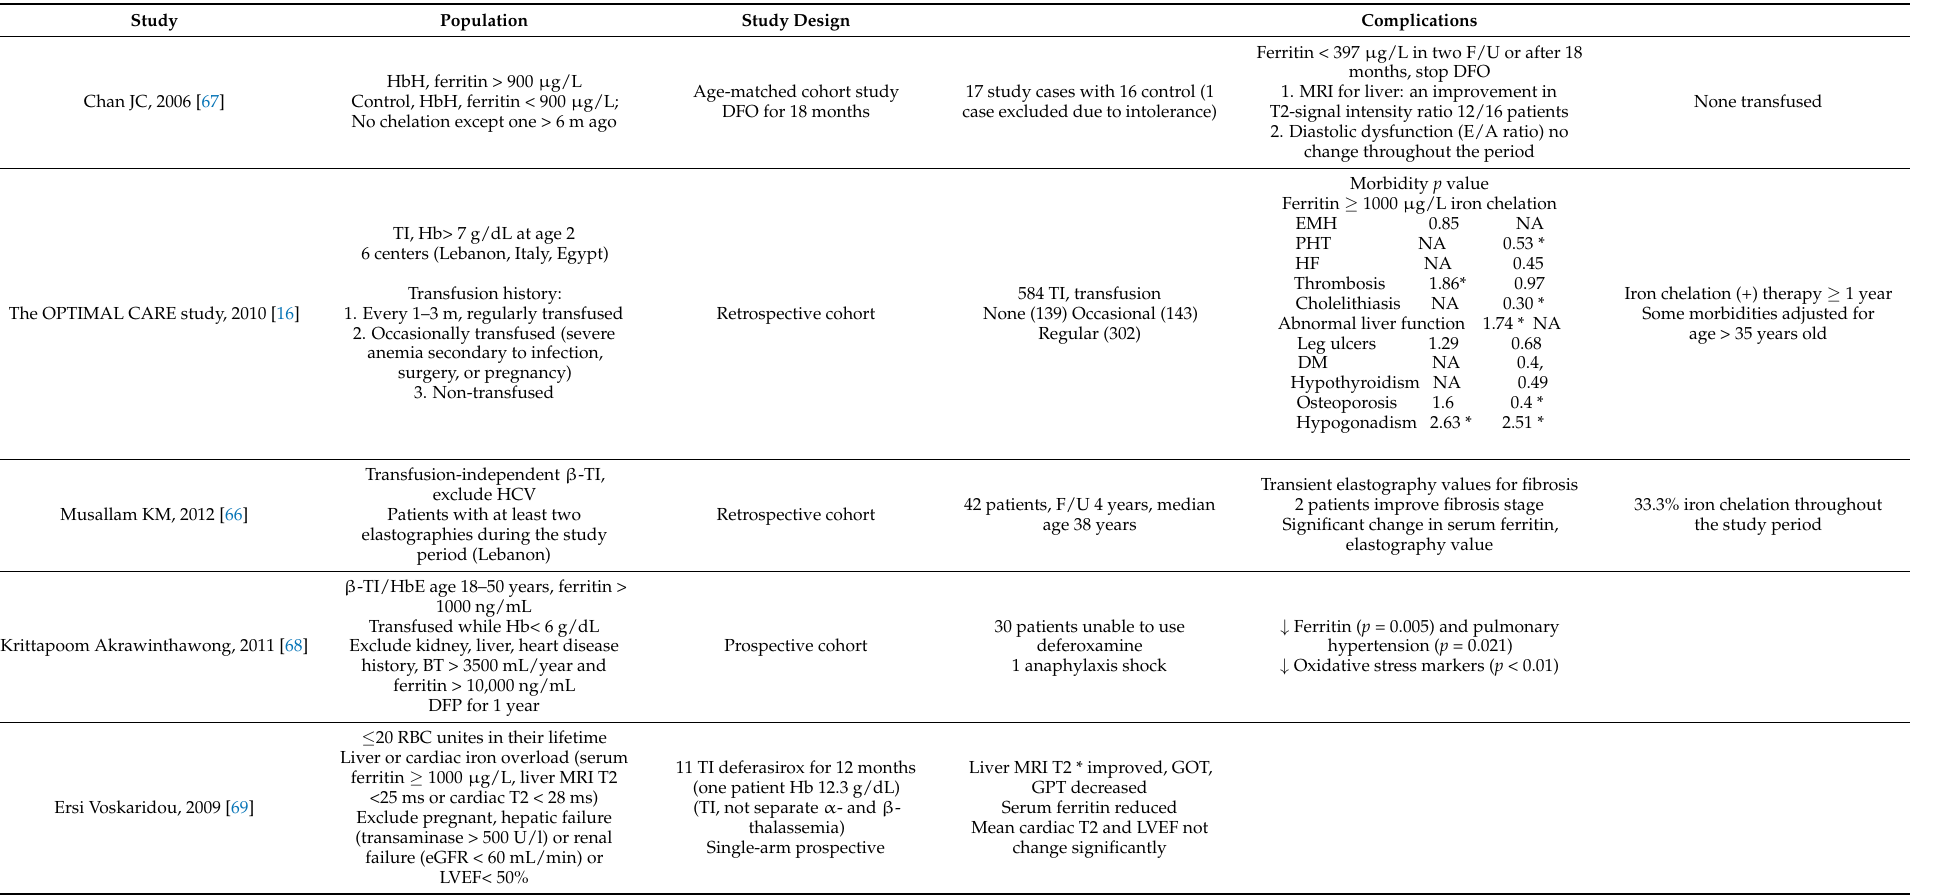
Table 6. Experiment studies: decrease ferritin, decrease